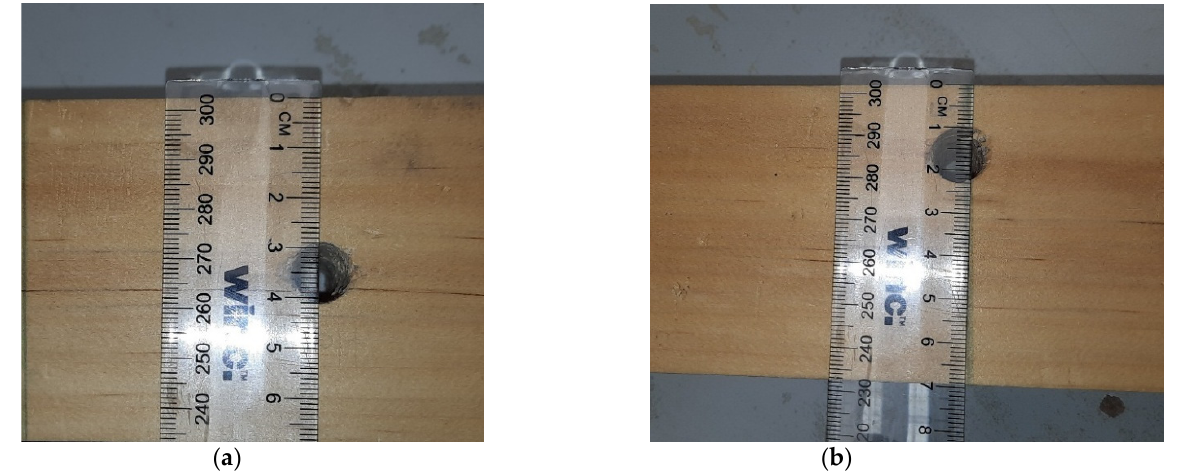
Figure 9. Cavities in the wood beam: ( a ) hole is 10 mm from measurement surface; ( b ) hole is 30 mm from measurement surface.